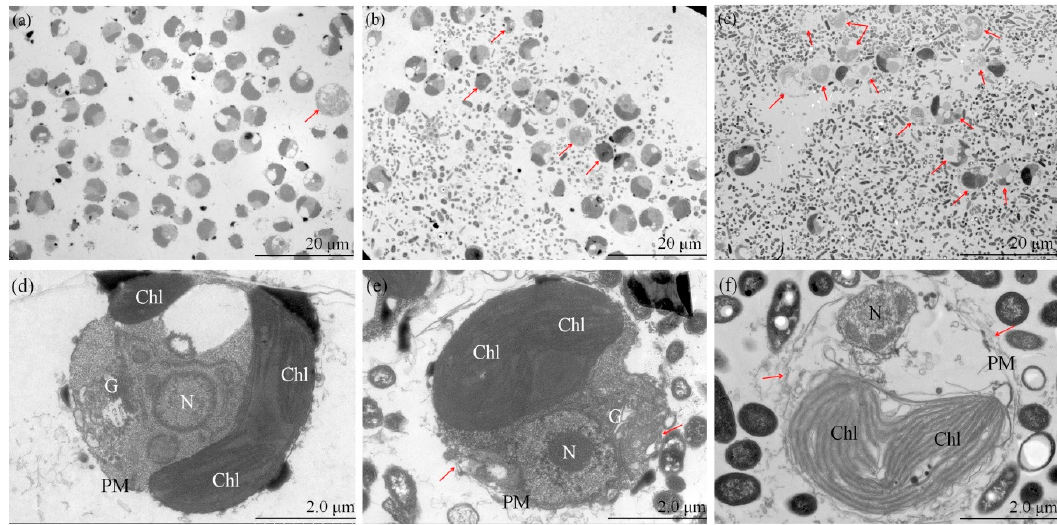
Figure 4. The ultrastructure of P. globosa sampling at 48 h. ( a , d ) represented Control, ( b , e ) represented the 1 mg/mL treatment group, ( c , f ) represented the 4 mg/mL treatment group. Abbreviations: N: nuclei, Chl: chloroplast, PM: plasma membrane, G: Golgi apparatus, Red arrow: deformed or damaged structure or cell.